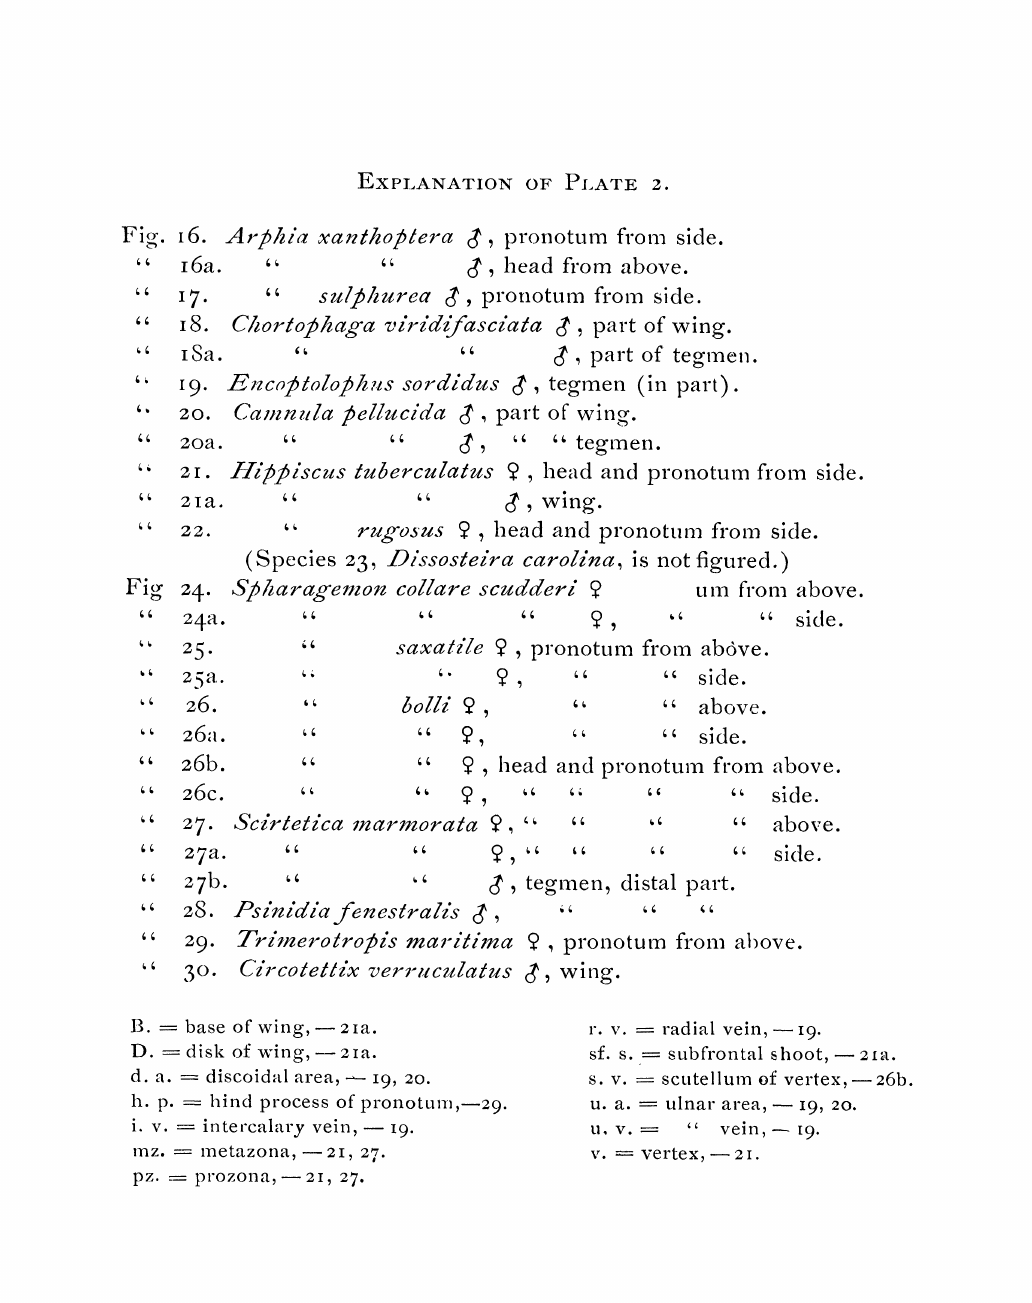
Fig. t6. Arpaia xant@tera